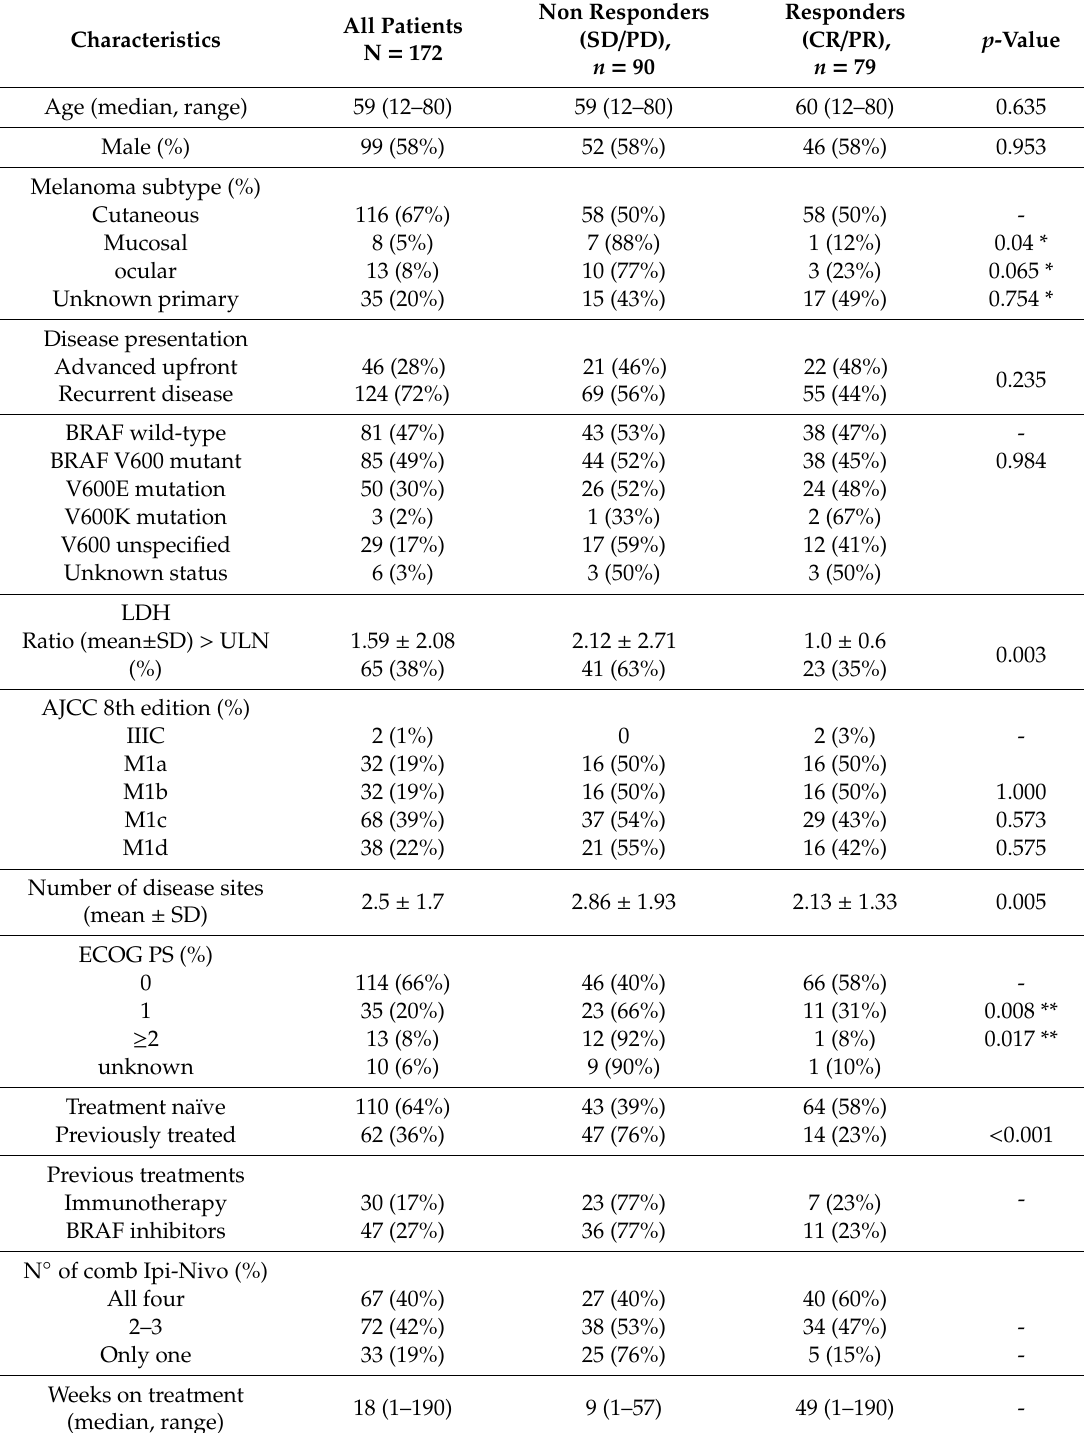
Table 1. Baseline patient